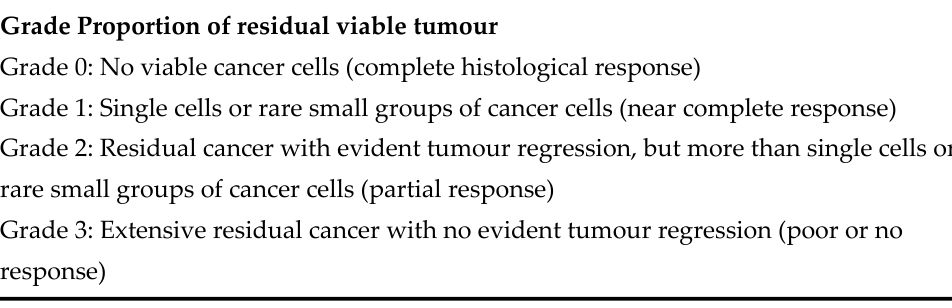
Figure 6. CAP tumour regression grading system.